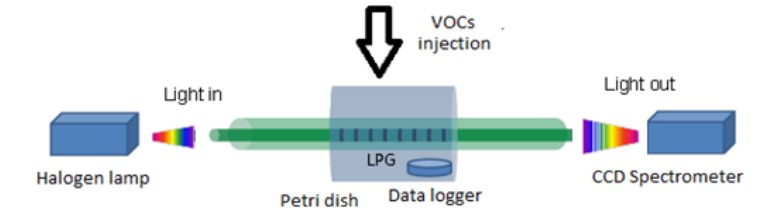
Figure 2. Scheme for VOCs sensitivity experiments.